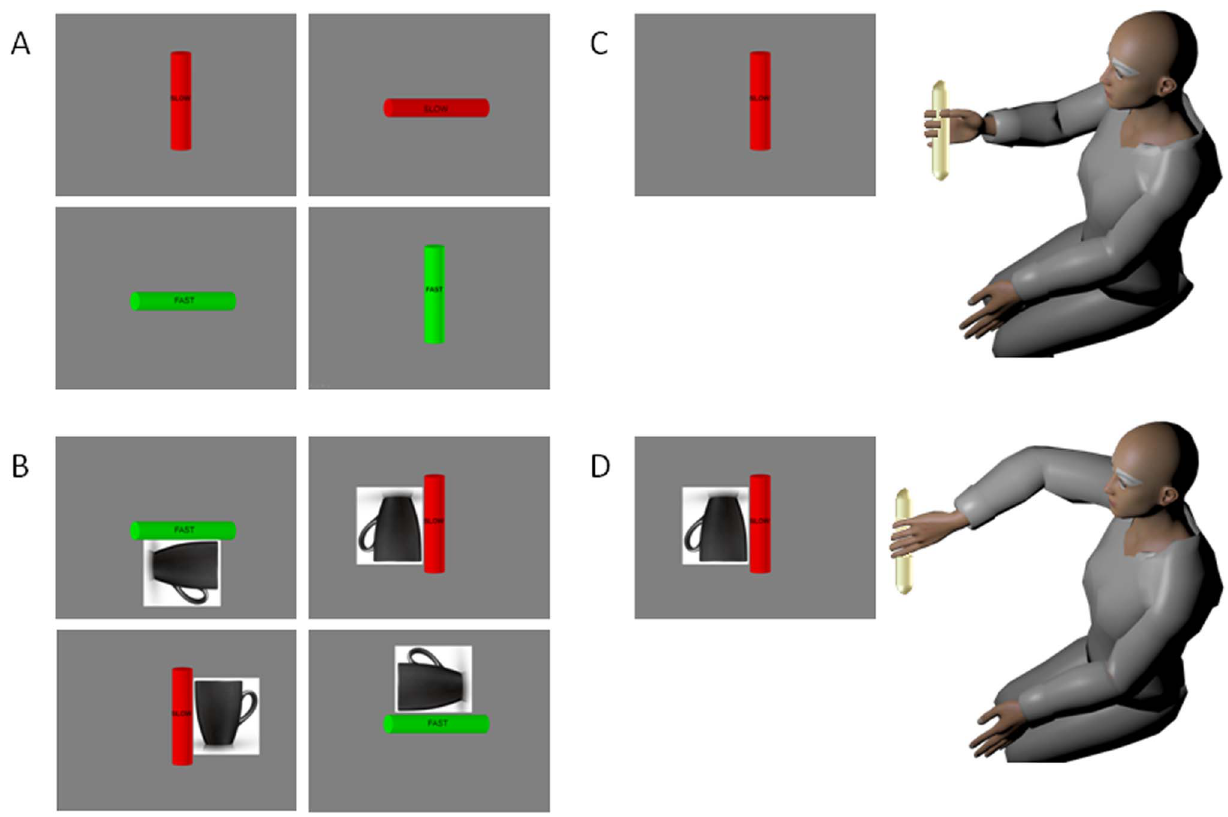
Figure 1. Priming Experiment to increase the cognitive load of a simple reach-to-grasp task. (A) Rods rendered in three dimensions were presented on the computer screen at 1 of 5 possible locations (shown here at the center location) at the four corners and at the center of the monitor. Color indicated the target speed (red-slow and green-fast). Speed was also labeled at the center of the cylinder. The target orientation could be horizontal or vertical. Because of redundancy in the degrees of freedom at multiple joints of the arm, each one of these oriented cylinders affords more than one arm-hand orientation. Subjects were free to choose the final orientation in the DEFAULT condition. (B) The primed condition instructed the subjects to use a particular target orientation while matching the hand-held cylinder to the simulated cylinder on the screen. The subjects were instructed to pick the orientation as though they were going grab the cup and drink from it. This instruction evoked a precise arm- hand orientation that was generally different from the DEFAULT one chosen by the subject in the first block. The primed-UP case required the same orientation as the DEFAULT but the primed-DOWN case required mental rotation to align the hand to the cup as if ‘‘picking it up to drink from it’’. This orientation cue evoked rotations at the arm joints and at the hand that were unambiguously different from the DEFAULT and primed-UP cases. (C) An example of a DEFAULT arm-hand orientation evoked by the cylinder oriented vertically and positioned at the center of the screen. (D) The same canonical orientation of the cylinder evokes a very different arm posture and a different hand orientation during primed-DOWN.